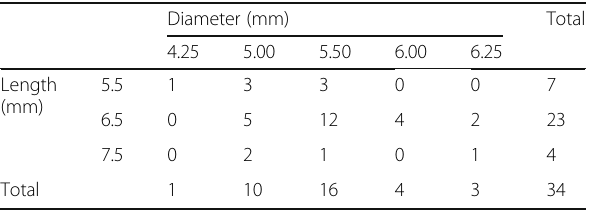
Table 1 Length and diameter of the dental implants in the experimental group